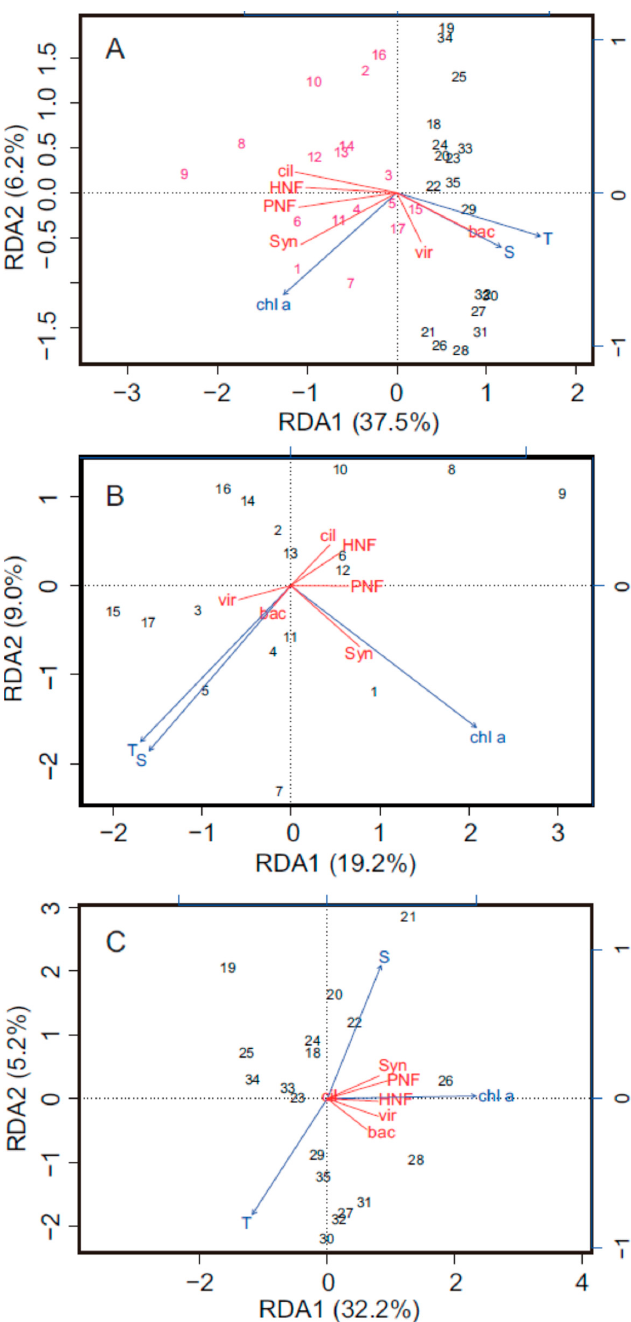
Figure 7. Redundancy analysis (RDA)-based microbial community composition (bac = bacteria, vir = viruses, HNF = heterotrophic nanoflagellate, PNF = pigmented nanoflagellate, cil = ciliate, and Syn = Synechococcus spp.), and environmental conditions (chl a = chlorophyll a, T = temperature, S = salinity) as the explanatory variables, for all data ( A ), northern part ( B ), and southern part ( C ) of the Taiwan Strait. In (A), samplings from northern part and southern part of the Taiwan Strait are labeled using magenta and black, respectively. The percentages of the community composition variation explained by the first and second RDA are labeled on the two axes of each RDA plot. The explanatory environmental conditions and microbial compositions are presented as blue arrows and red lines on RDA plots, respectively.